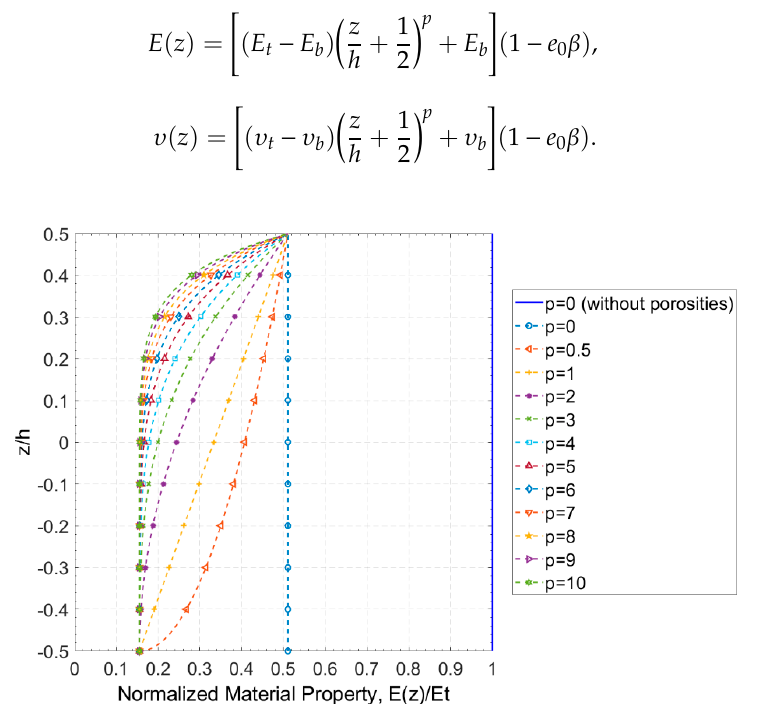
Figure 3. Normalized: ( a ) porosity model M1 and ( b ) Young’s modulus (E(z)) through the thickness direction.